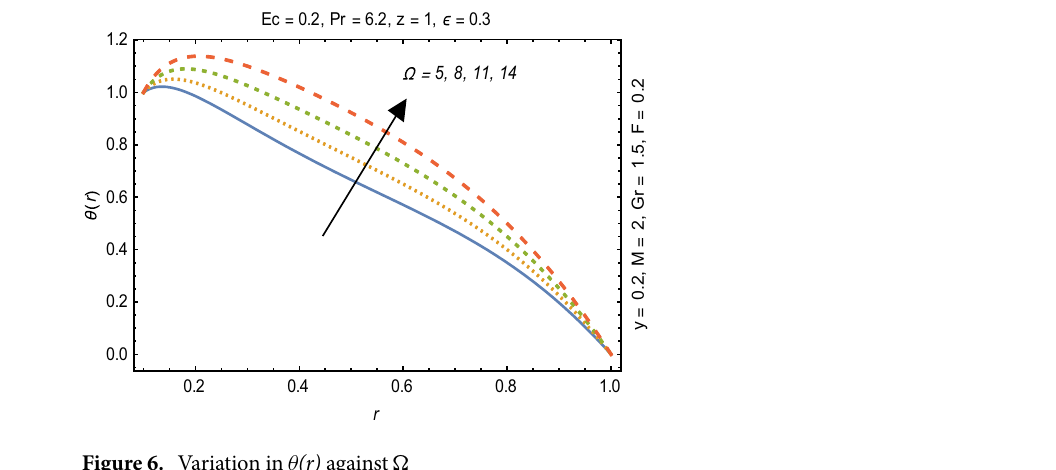
Figure 6. Variation in θ (r) against (cid:31) .